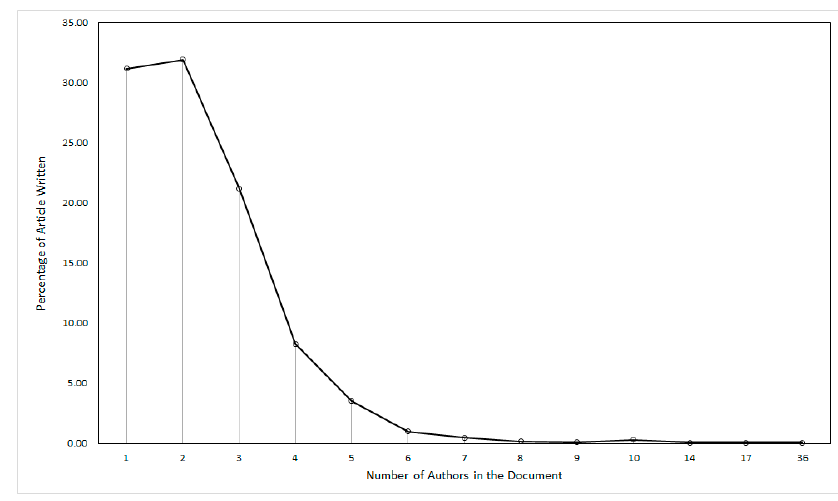
Figure 4. Authorship pattern of green product research.